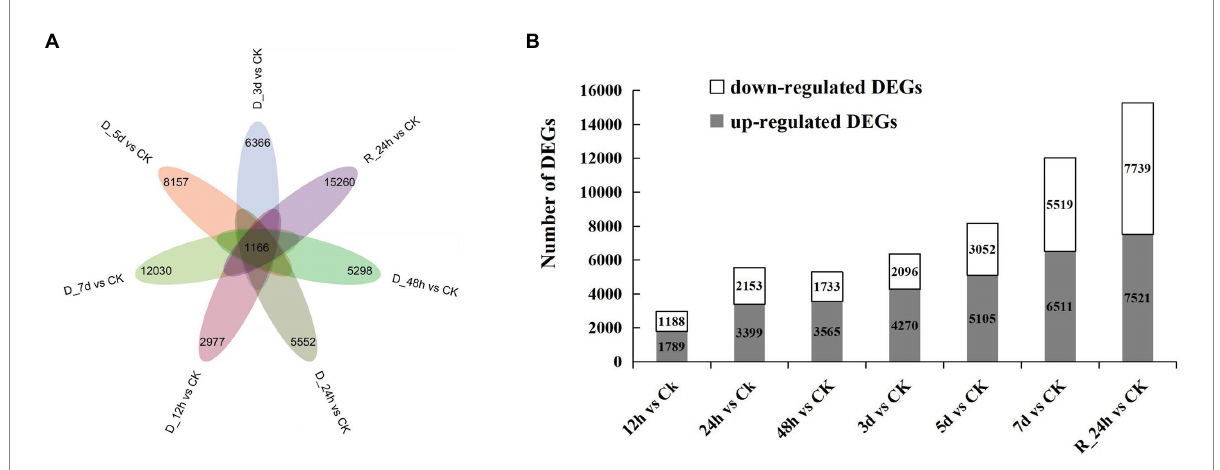
FIGURE 2 Drought responsive genes in Agropyron mongolicum . (A) Venn diagrams of differentially expressed genes in the treatment and control groups. (B) The number of differentially expressed genes under drought stress compared with the